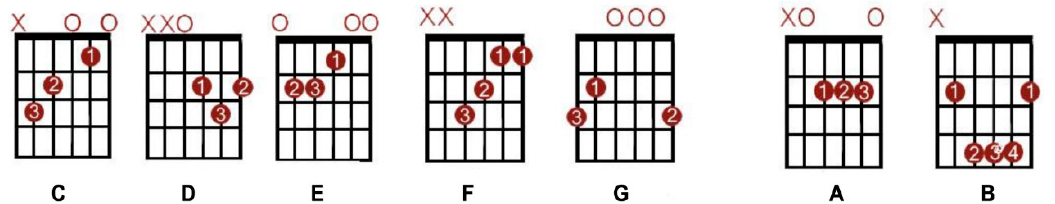
Figure 4. Chord chart of seven major chords. Numbers indicate where should fingers be placed on the fret board of the guitar.